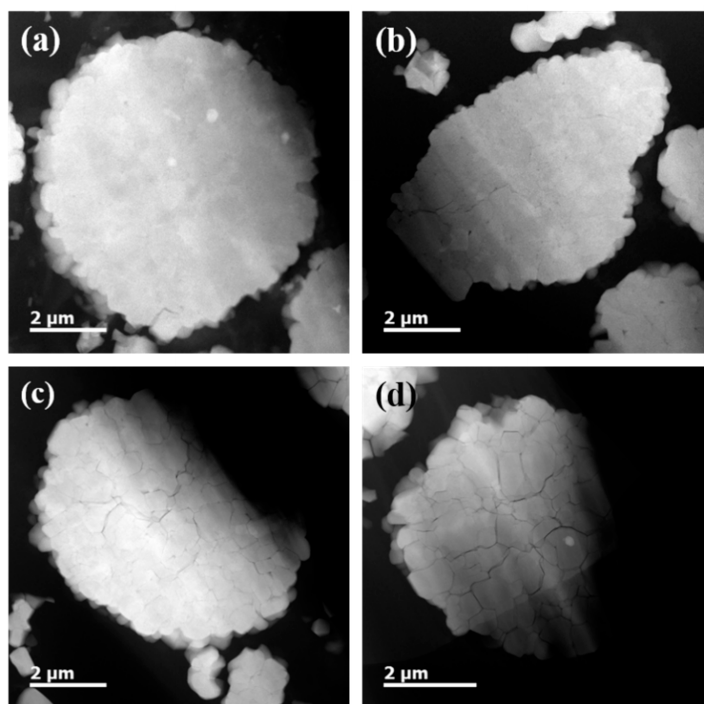
Figure 4. Cross-sectional STEM images of NCM811 after 50 cycles depending on the charging voltage: ( a ) before cycling at the open-circuit voltage (OCV), ( b ) 4.05 V, ( c ) 4.3 V, and ( d ) 4.5 V versus Li/Li + .